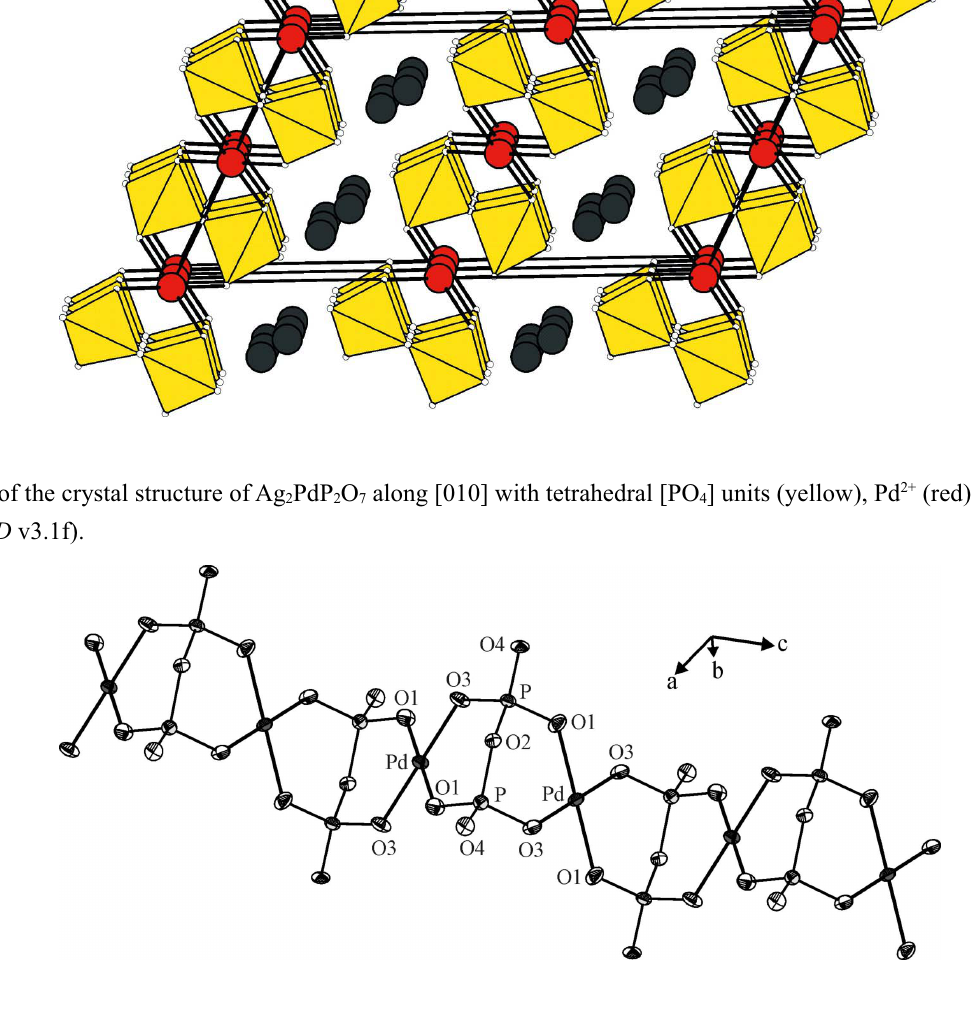
] units (yellow), Pd 2+ (red) and Ag + grey 4